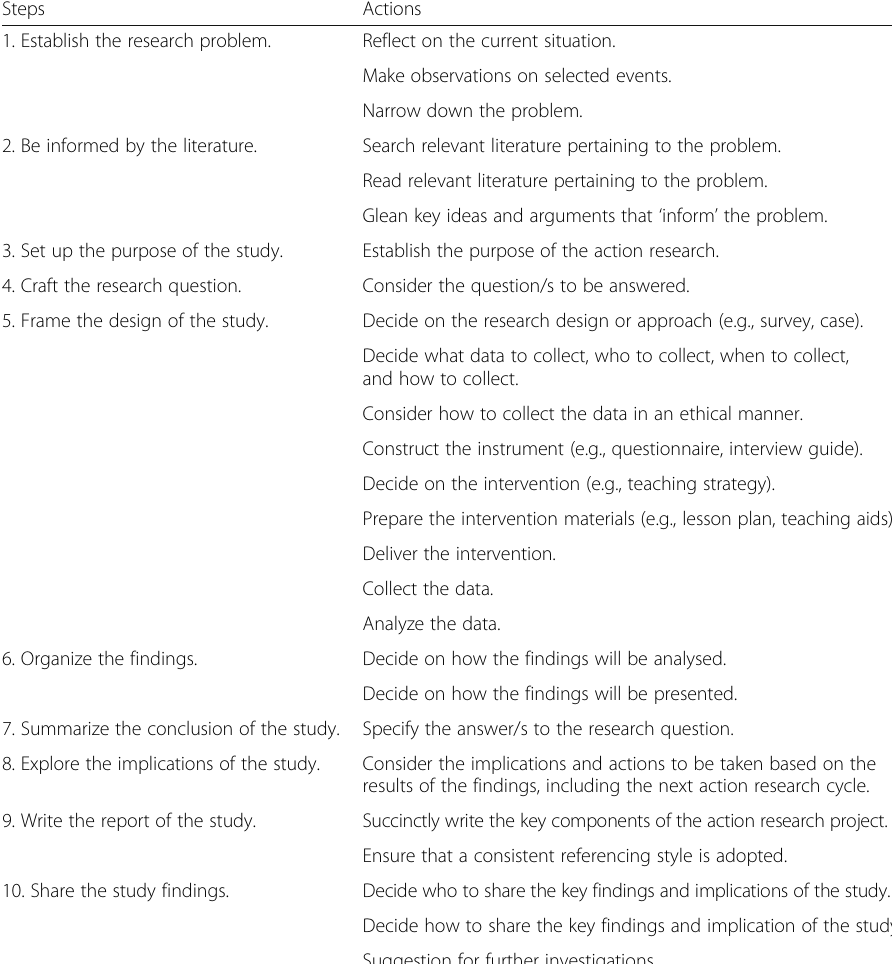
Table 1 Step and actions in an action research cycle